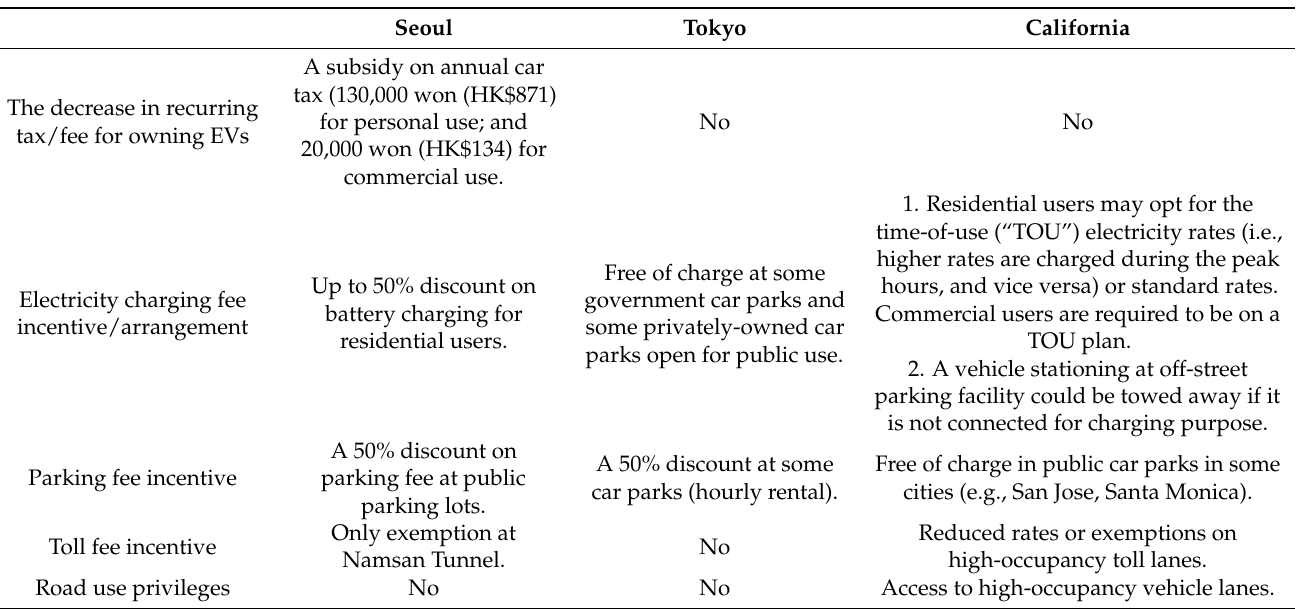
Table 2. Strategies for Improving the Adoption of